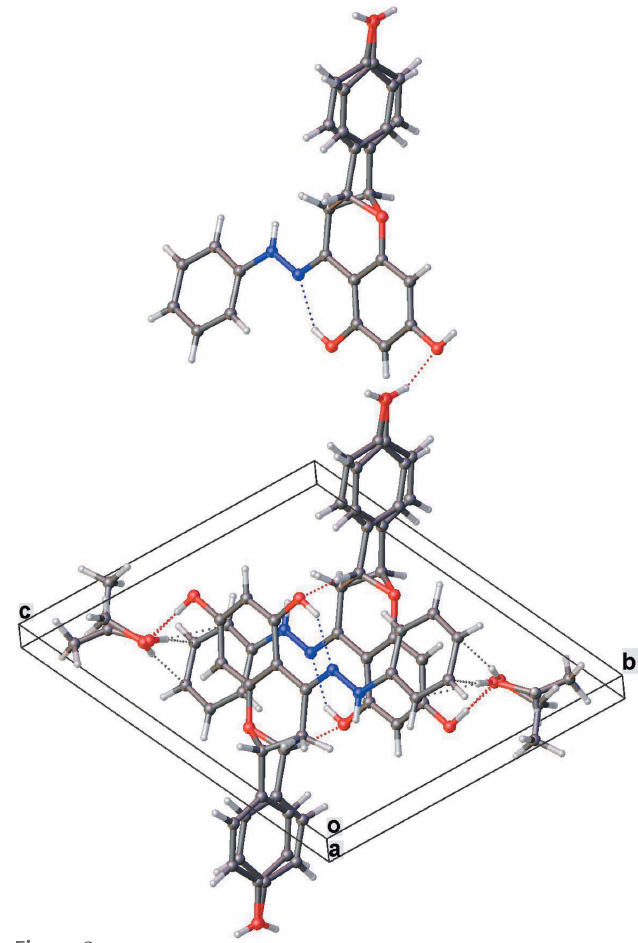
Figure 2 Crystal packing diagram showing intramolecular O—H (cid:2)(cid:2)(cid:2) N and inter-